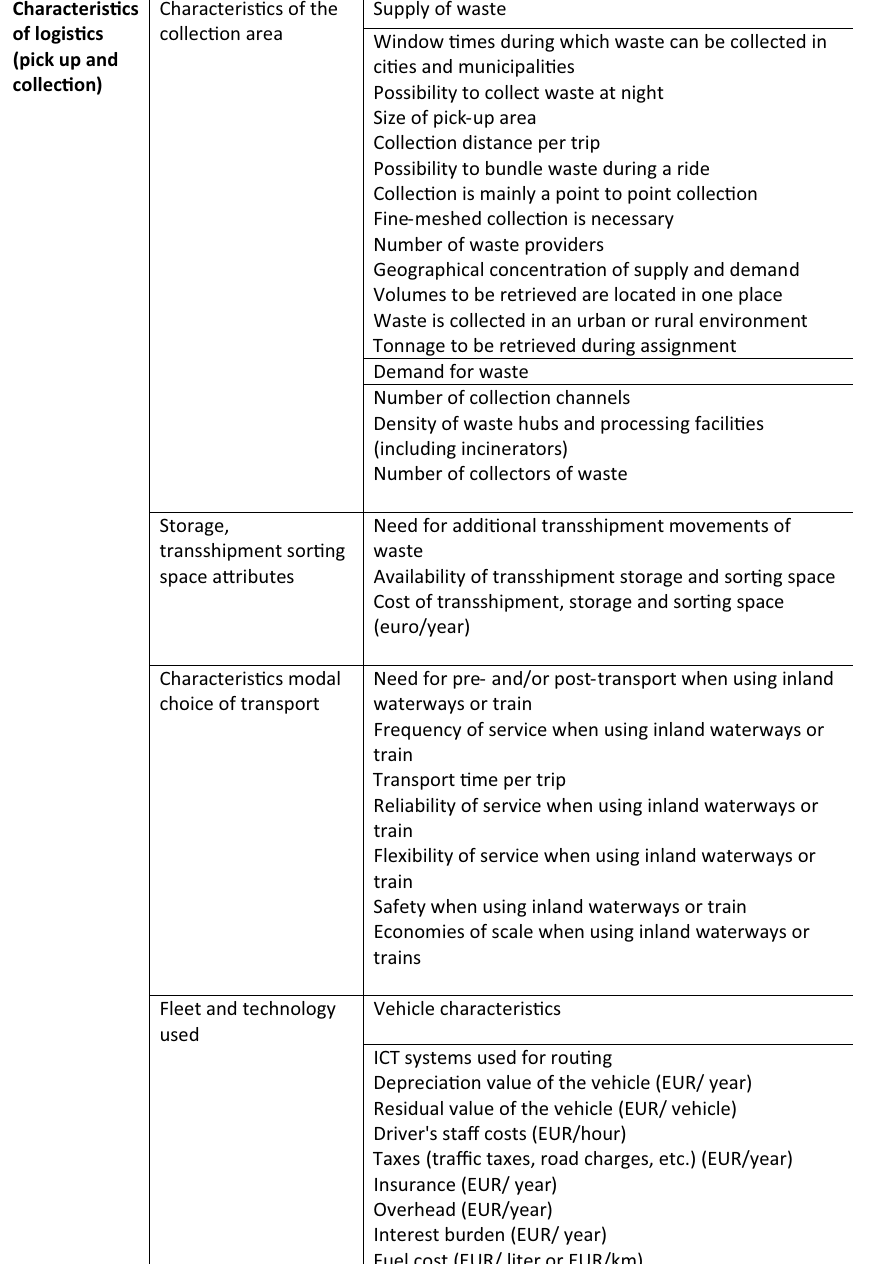
Fig. 4 Different characteristics of the parameters explained. Source: Own